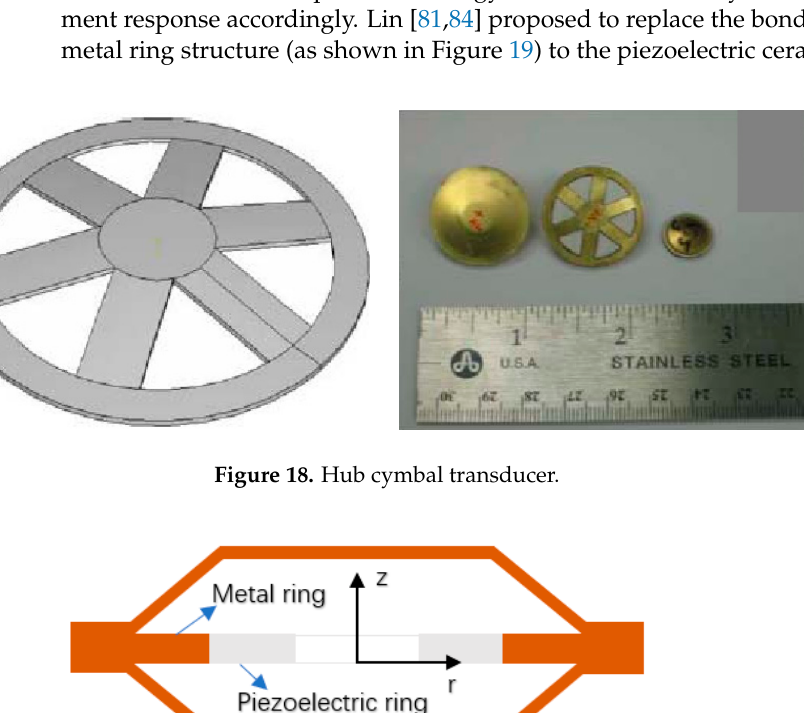
Figure 19. Structure diagram of cymbal with piezoelectric ring and metal ring.